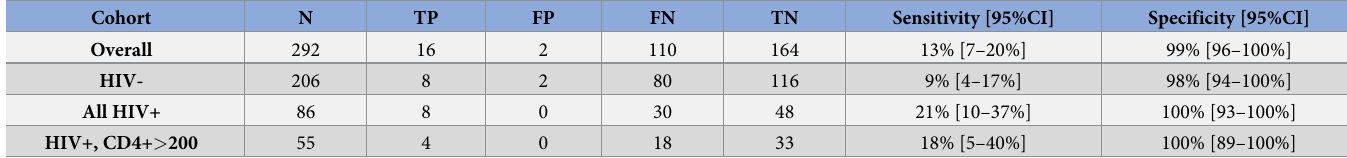
Performance shown for the overall cohort and by HIV-status. For HIV+ patients, the performance is also presented stratified by CD4+ T-cell count. TP = true positive; FP = false positive; FN = false negative; TN = true negative; CI = confidence